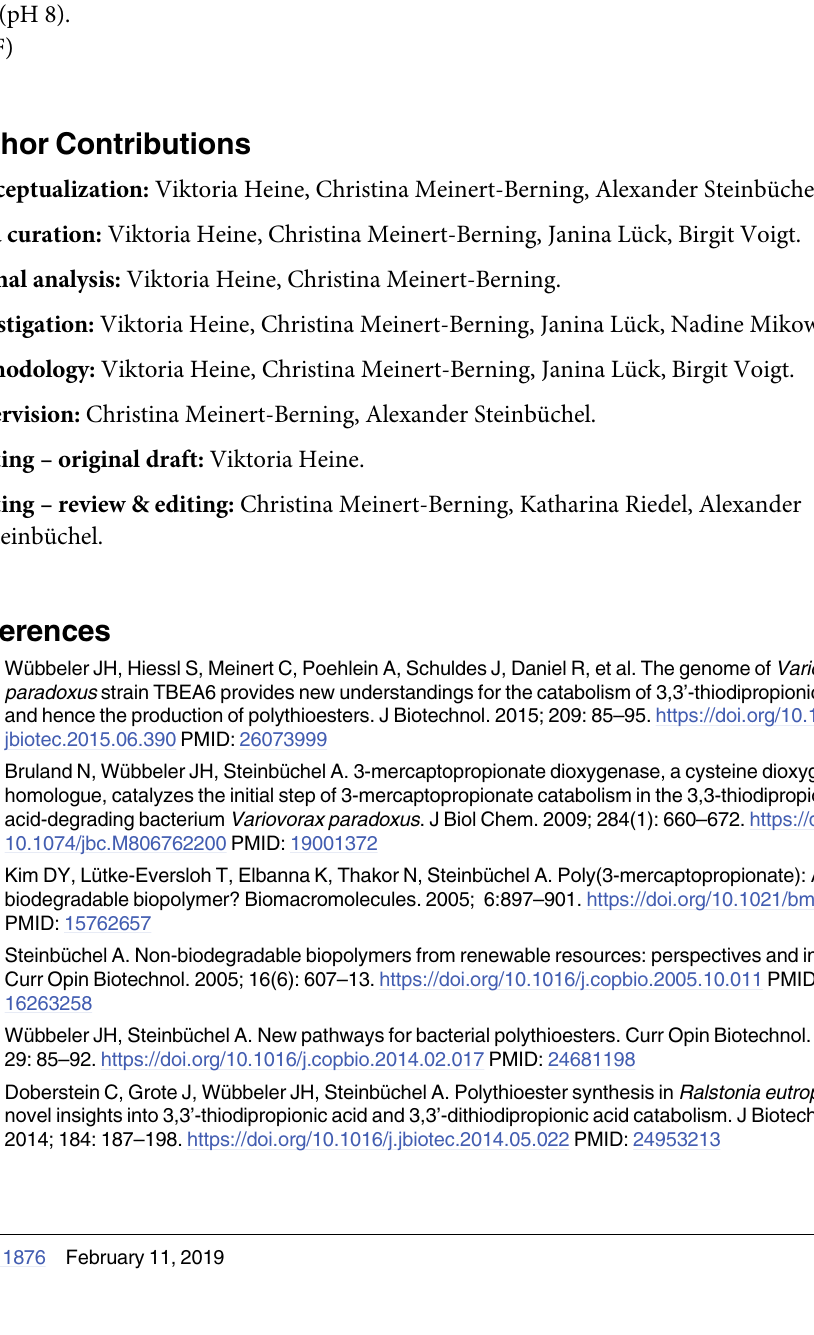
centrations of imidazole. Cells were mixed with binding buffer (20 mM imidazole) before cell disruption and afterwards cell debris was removed by centrifugation (cell-free lysate). The cell- free lysate was loaded onto the columns (flow through) and washed with the above mentioned Tris/HCl Buffer with the following concentrations of imidazole: wash fraction I, 50 mM imid- azole; wash fraction II, 100 mM imidazole; wash fraction III and IV, 200 mM imidazole. The protein was eluted using the Tris/HCl buffer with 500 mM imidazole. S5 Fig. Thermal shift assay of purified Ech-30 using TDP (green) and TDP-CoA (red) as ligands. The blue curve represents the no ligand control. The lines without the peaks represent the no protein controls, also with addition of TDP (green) and TDP-CoA (red). The assay was performed in triplicate with 2 μ M protein in presence of 2 mM TDP-CoA in 100 mM Tris/ HCl (pH